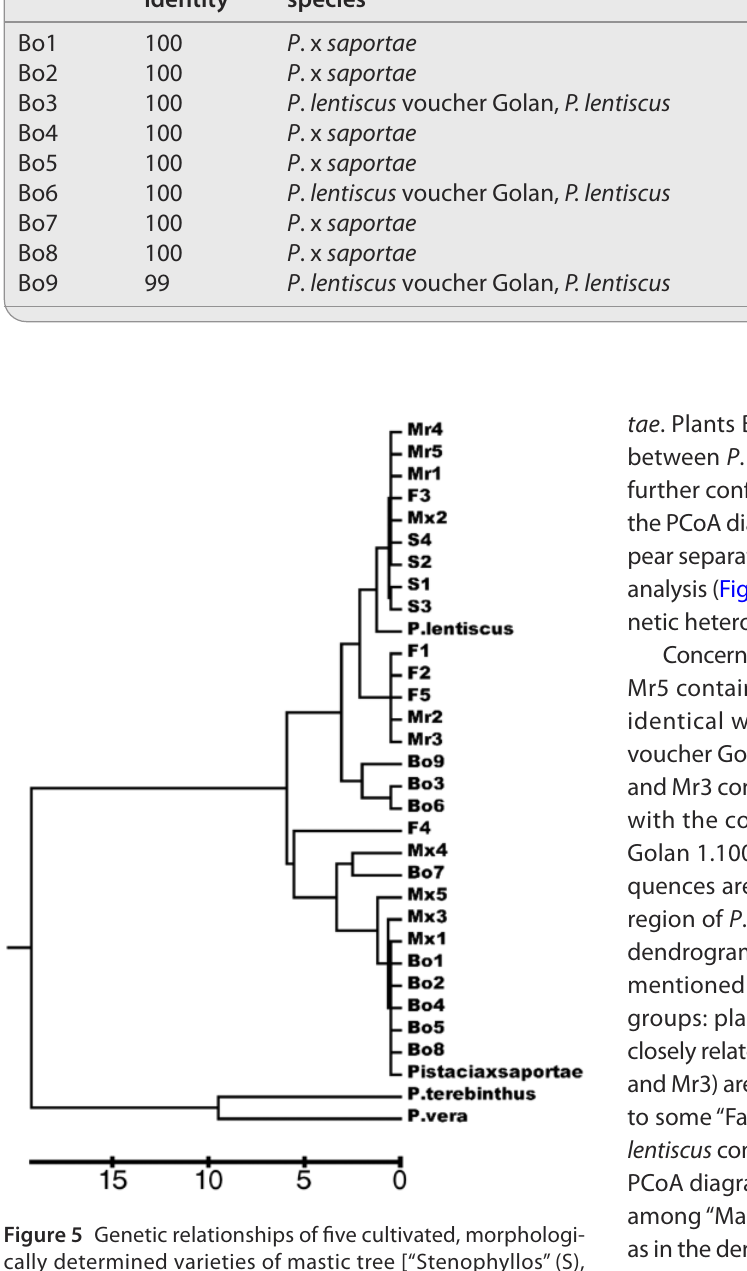
Table 4 Composition of the ITS1 and ITS2 sequences of plants belonging to “Votomos” (Bo) Plant